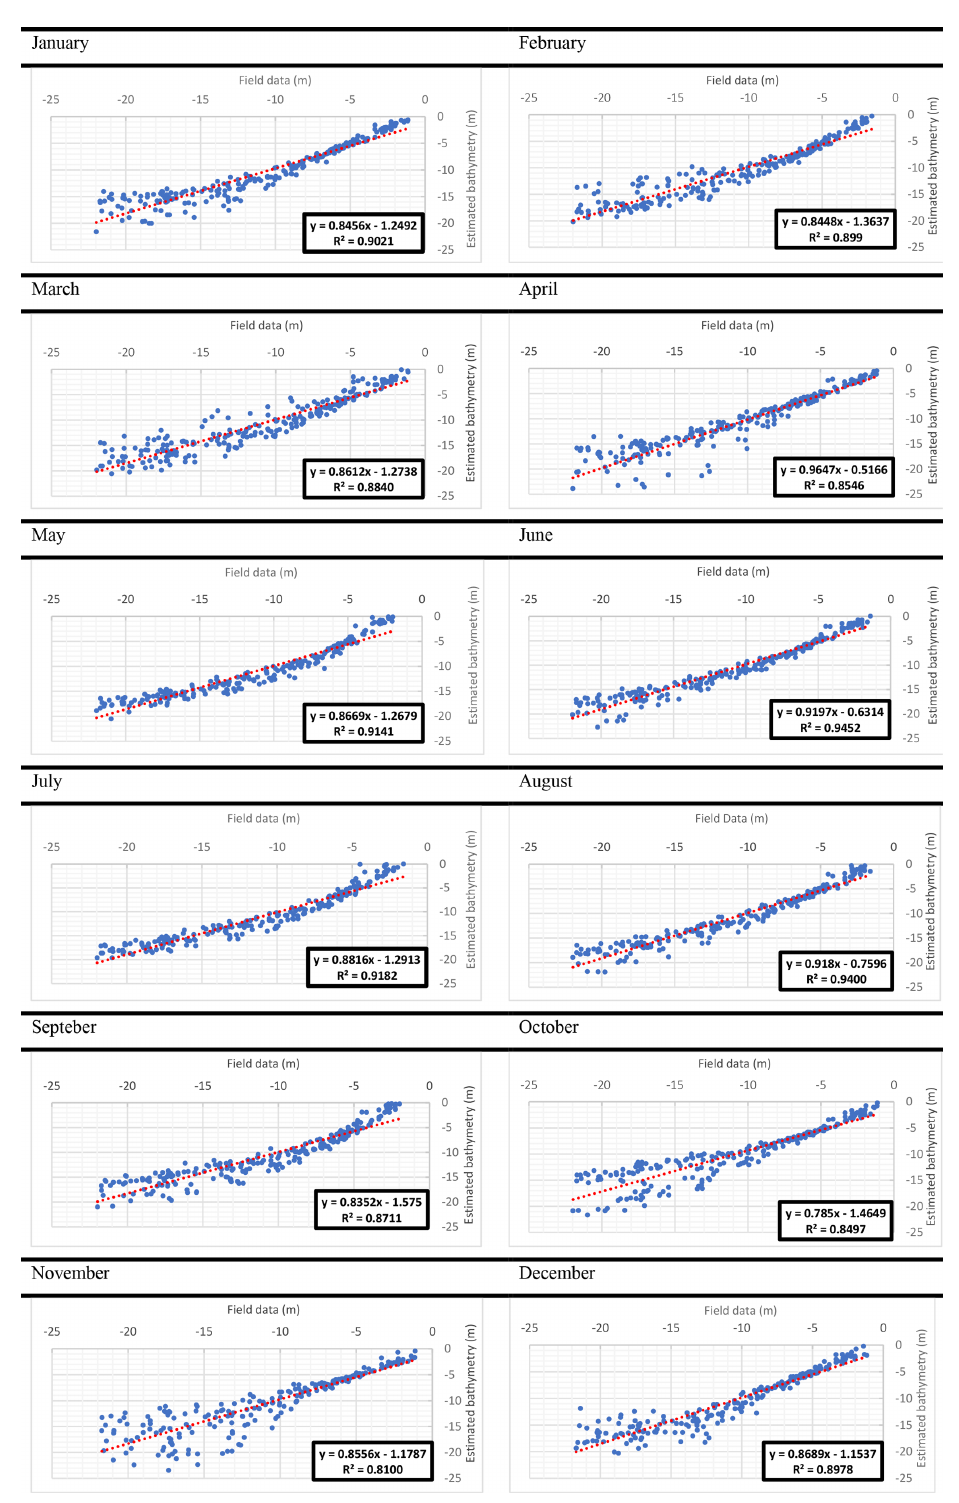
Figure 4. Correlation between observed depths and SDB depths obtained for each